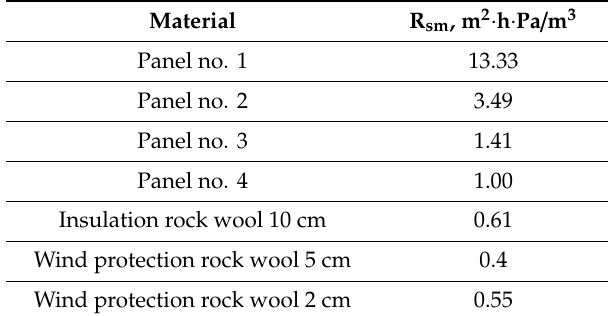
Table 2. The specific air resistance of the materials used in